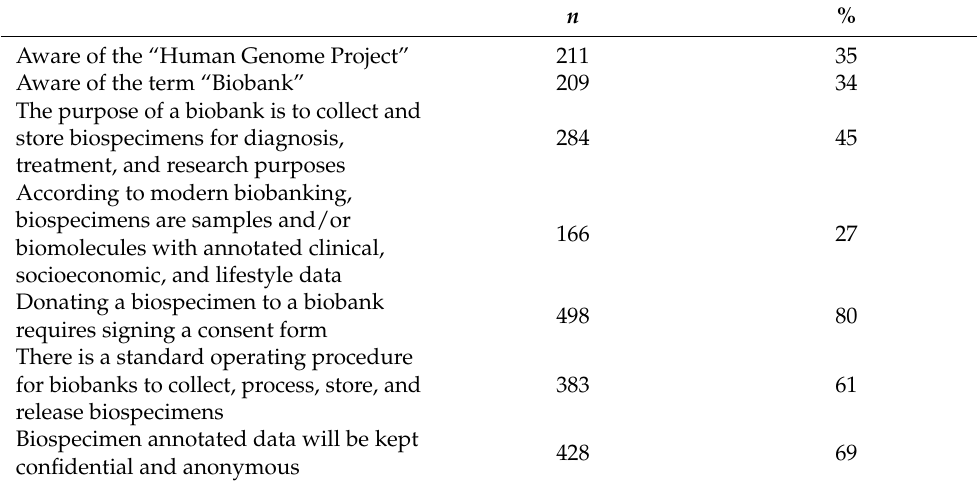
Table 2. Knowledge about biobanking ( n = 636).